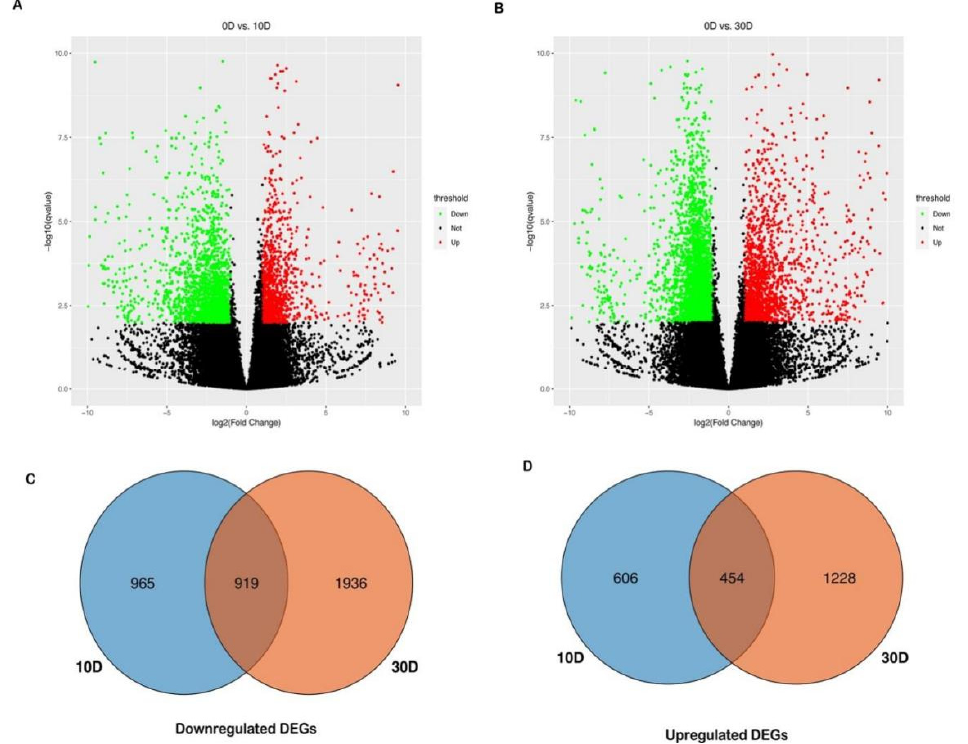
Figure 2. Differential gene expression in sensitive cultivar LC05 − 136 treated by PBZ at 10 d and 30 d. ( A ) Differential expression analysis of samples between 0 d and 10 d; ( B ) Differential expression analysis of samples between 0 d and 30 d; ( C ) Venn analysis of downregulated DEGs between 10 d and 30 d; ( D ) Venn analysis of upregulated DEGs between 10 d and 30 d.